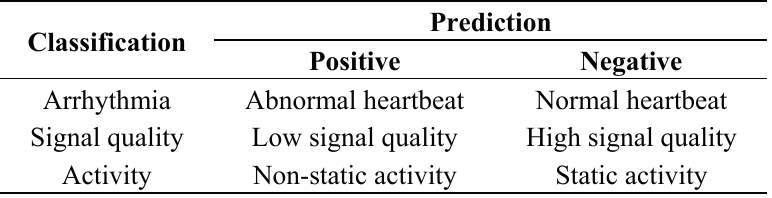
Table 6. The meanings of positive predictions and negative